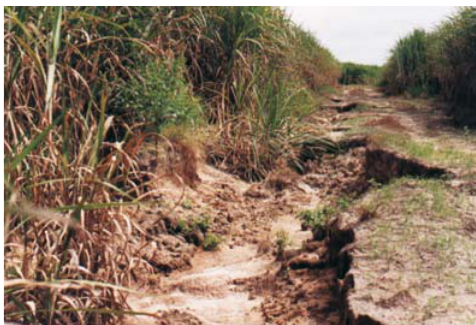
Figura 10. Feição erosiva na área, ocupada com cana- de-açúcar sobre Argissolo Vermelho-Amarelo distrófico